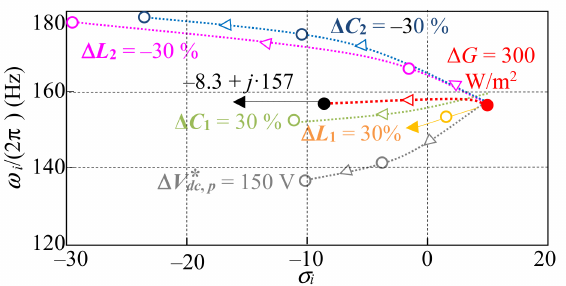
Figure 8. Analysis of the PV system stability improvement ( ∆ < 0 means that the variable is reduced, while ∆ > 0 means that the variable is